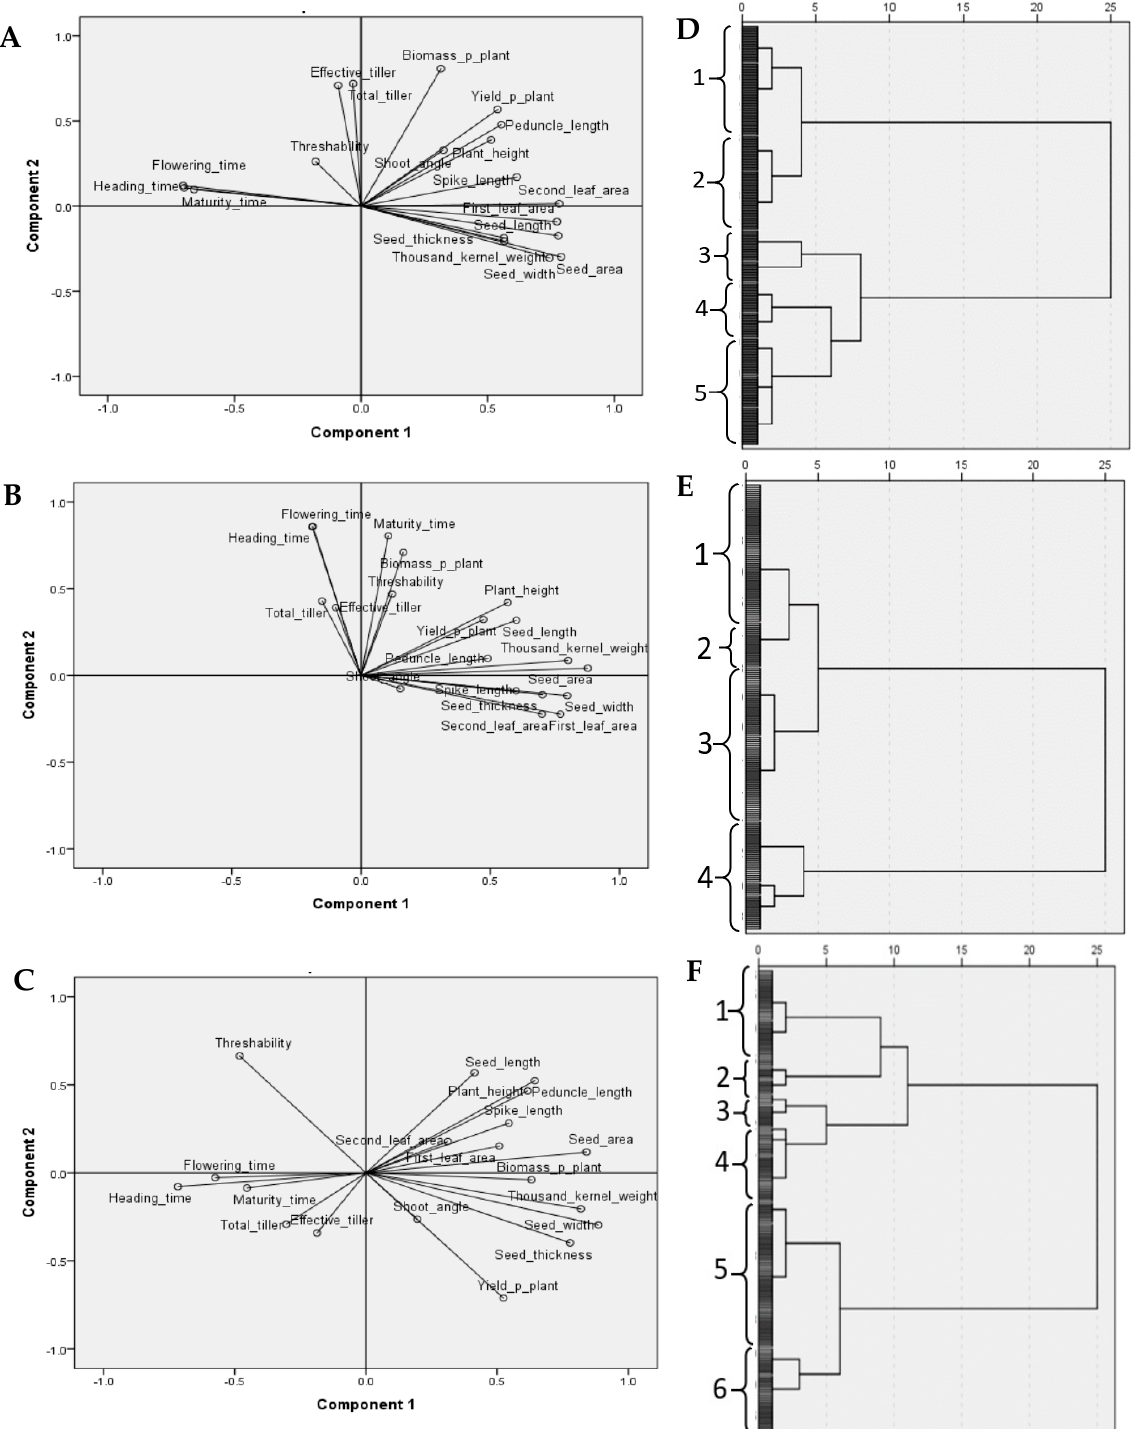
Figure 2. Component plot produced from principal component analysis on the aboveground traits of wild emmer accessions for E1 ( A ), E2 ( B ), and E3 ( C ); Biplot vectors are trait factor loadings for PC1 and PC2. Dendrogram shows grouping of accessions into clusters for E1 ( D ), E2 ( E ), and E3 ( F ) using corresponding principal component analysis.